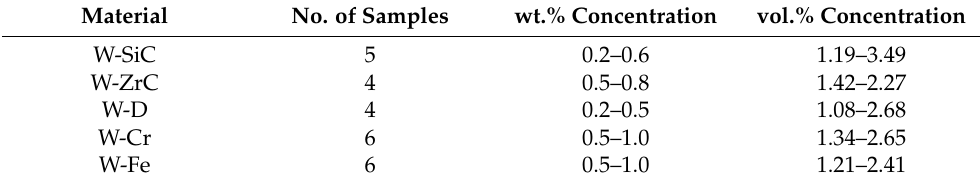
Figure 1. SPS cycle used to produce the samples for fast-forward screening. Table 1. Summary of the test materials’ compositions.